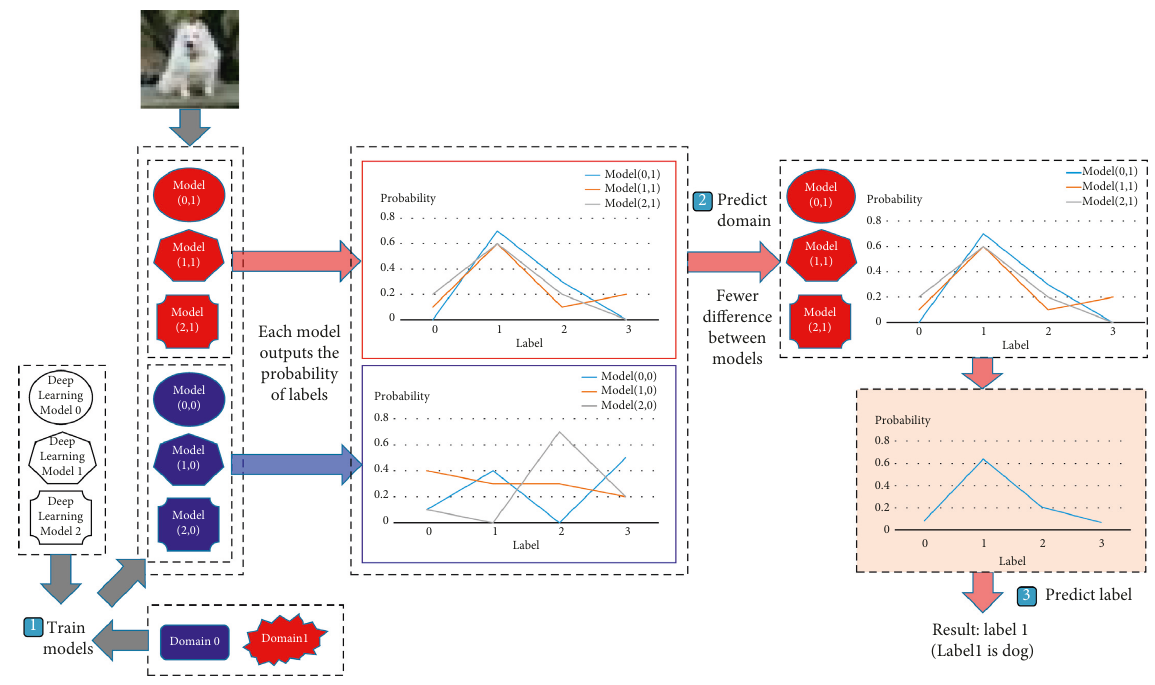
Figure 2: The illustration of the framework of our